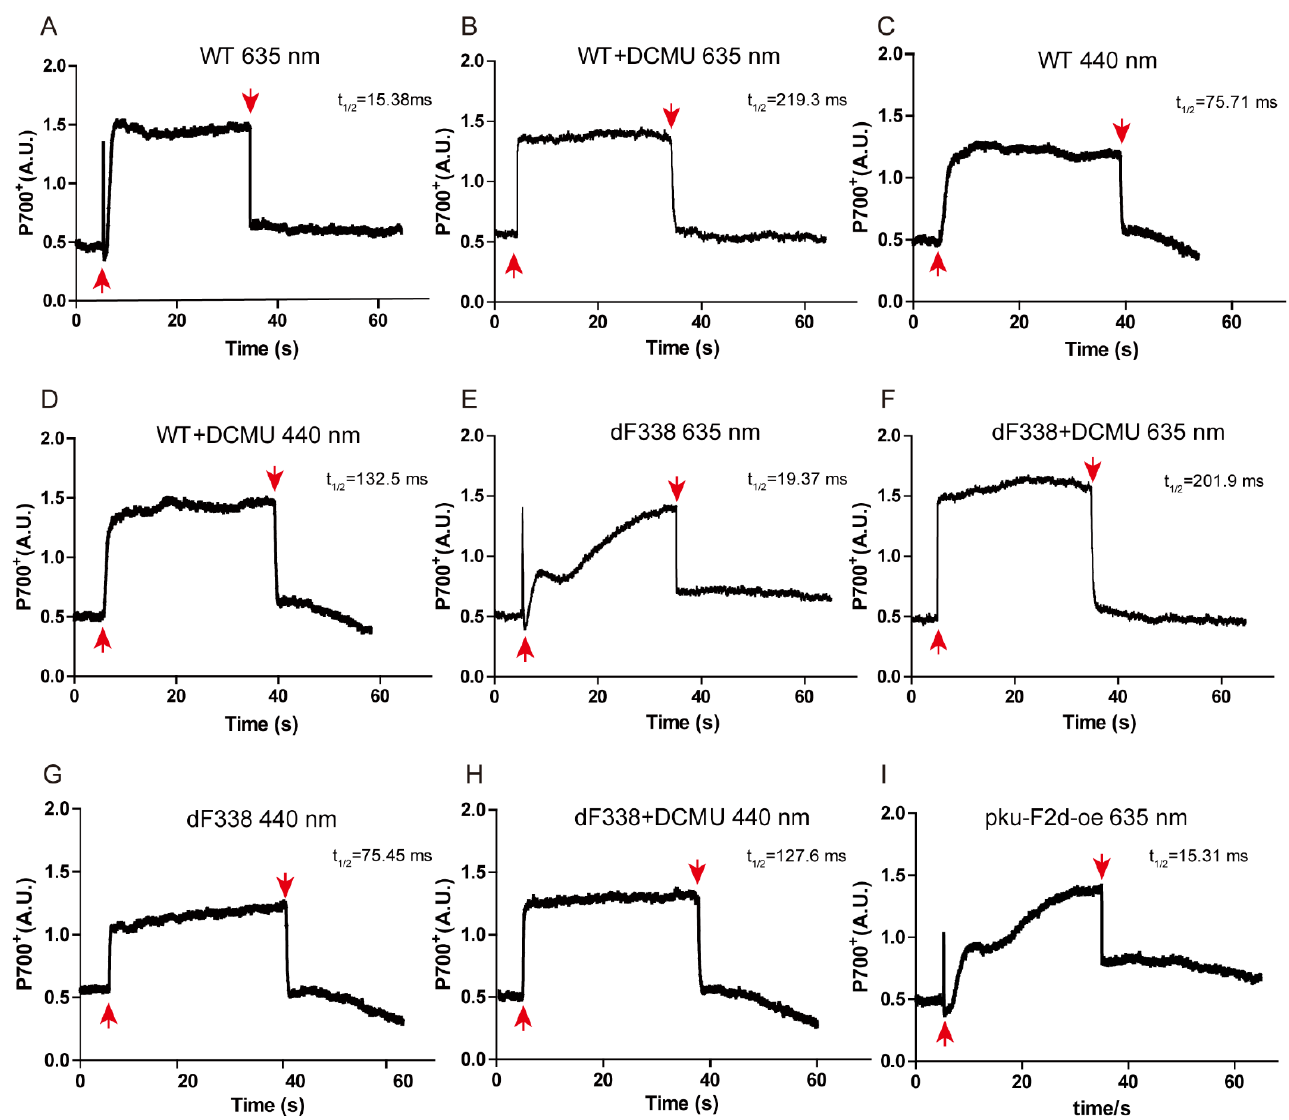
Figure 5. Kinetic analyses of P700 photooxidation and reduction of P700 + . Strains of WT (panels A – D ), dF338 (panels E – H ) and pku-F2d-oe (the strain that overexpresses the petH2D gene, panel I ) were incubated in the dark for 5 min before the actinic lights at 635 nm (panels A , B , E , F , I ) or at 440 nm (panels C , D , G , H ) were switched on. When needed (panels B , D , F , H ), DCMU was added at a concentration 10 μM before the dark incubation. The upward and downward red arrows in the panels indicate turning on or turning off of the actinic lights, respectively.